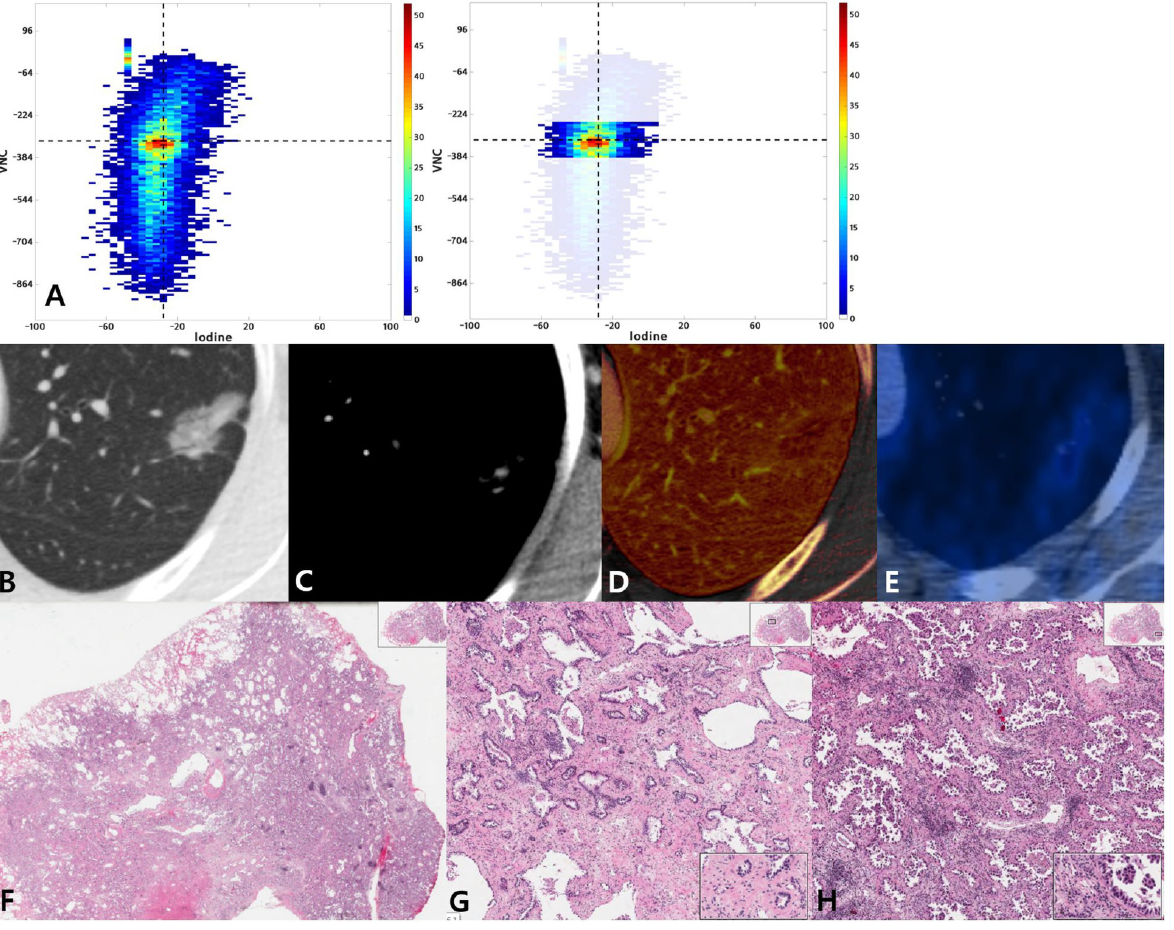
Figure 4. A 54-year-old woman with lung adenocarcinoma with a 70% acinar and 30% micropapillary pattern. ( A ) Joint histogram showing a taller than wide shape and compact distribution pattern. ( B ) Targeted view of the lung window VNC image shows a 24-mm-sized part-solid nodule in the left upper lobe. ( C ) On conventional enhanced image with mediastinal window, tiny areas of solid portion are seen. ( D ) On the iodine map, the range of mean iodine value was − 51 to 136. ( E ) PET/CT image shows FDG uptake with SUVmax of 1.6. ( F ) Photomicrograph (hematoxylin and eosin stain, 10×) shows invasive adenocarcinoma with acinar predominant pattern. High magnification (HE, 100×) shows acinar pattern ( G ) and micropapillary pattern ( H ) lung adenocarcinoma.